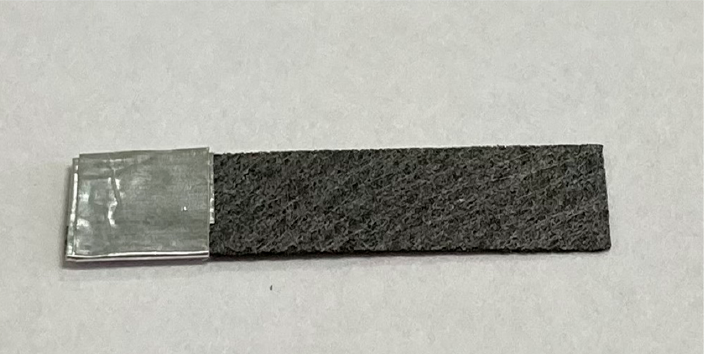
Figure 1. Homemade CPS with dimensions of about 2.5 × 0.7 cm 2 containing aluminum foil at one end for better connection. end for better